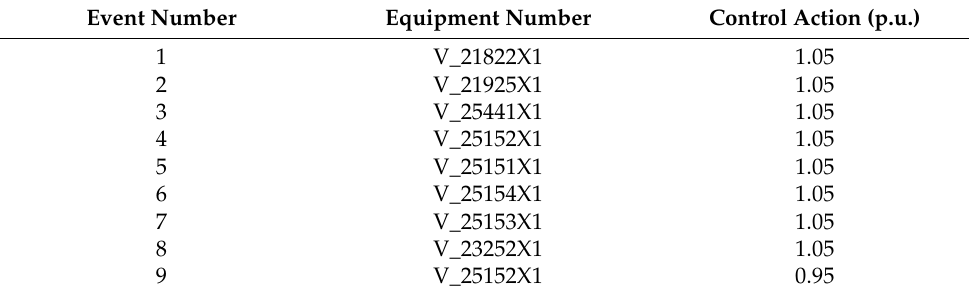
Table 3. Control output of the expert system. Event Number Equipment